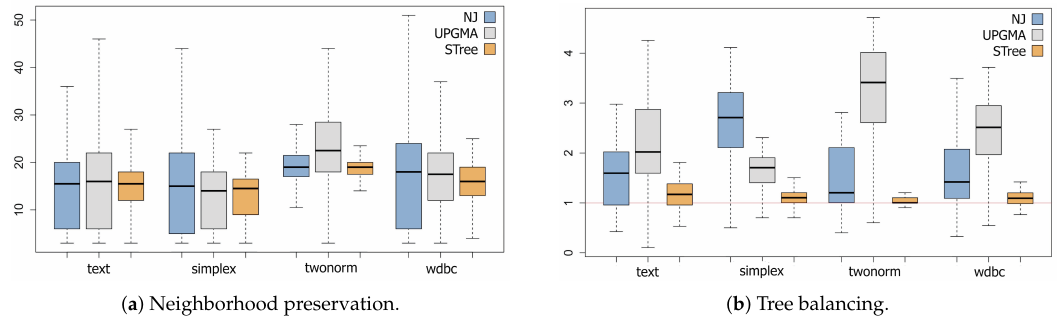
Figure 3. Boxplots comparing STree, NJ, and UPGMA techniques considering the four distinct datasets. STree presents similar or better neighborhood preservation if compared to more expensive techniques, with a smaller deviation, indicating a more stable structure ( a ). Also, STree produce more balanced trees potentially resulting in graph bundlings containing less distorted edges while making a better use of the visual space, reducing visual clutter ( b